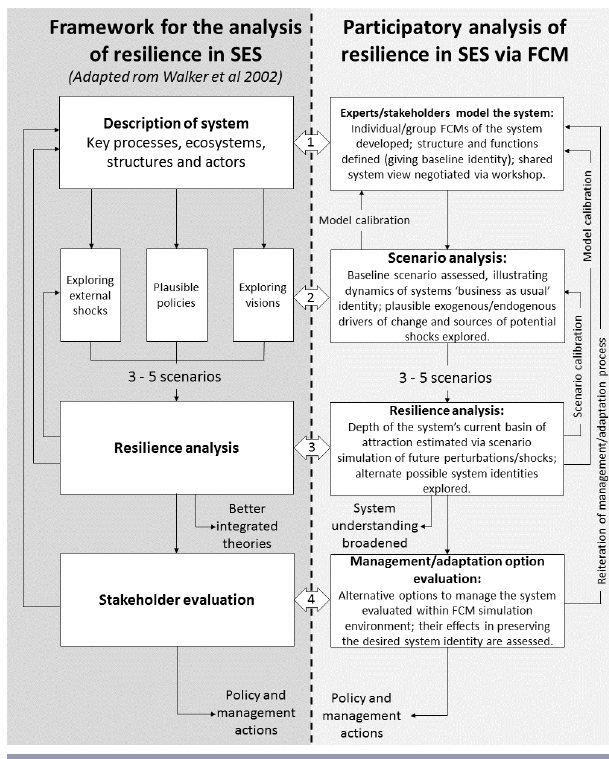
Fig. 2 . Mapping the participatory fuzzy cognitive mapping (FCM) approach to social-ecological system (SES) resilience assessment that we propose to the framework put forward by Walker et al. (2002).